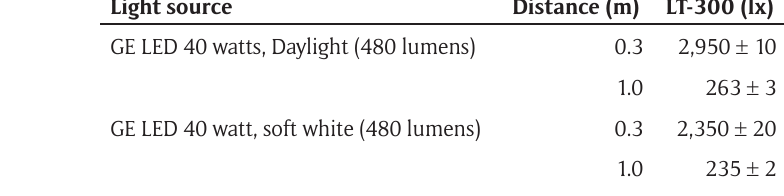
Table 5: Common light sources and their calibrated direct